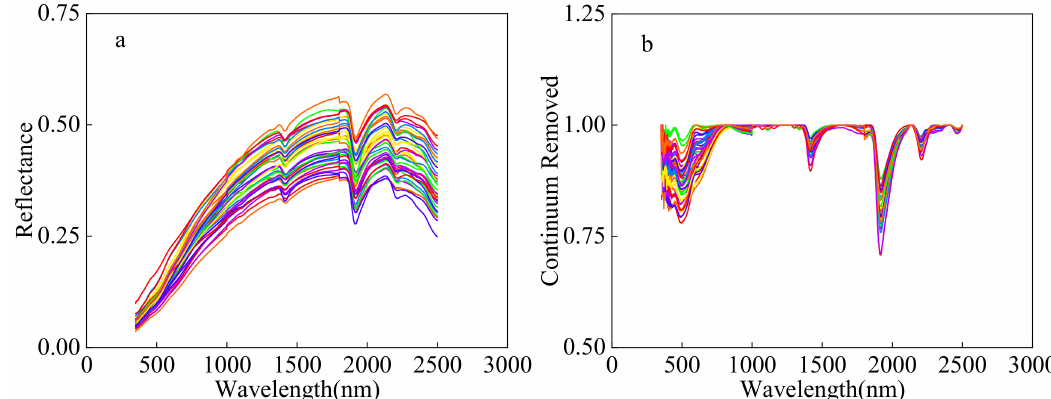
Figure 2. Laboratory spectral data: ( a ) raw spectral; ( b ) continuum-removal (the colored lines represent different sam- pling